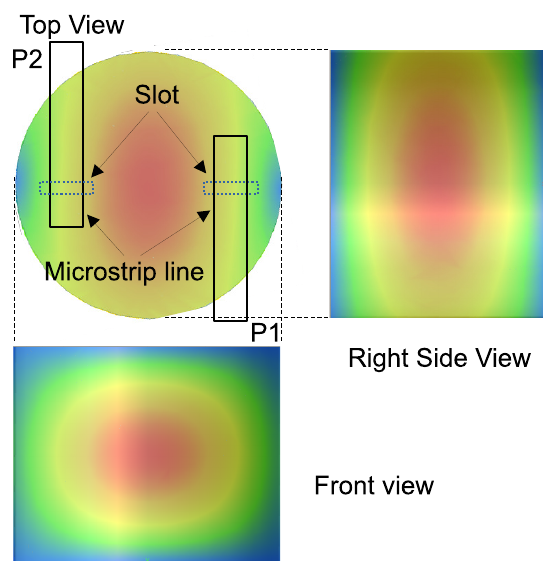
Figure 8. Electric field strength in the cavity resonator for TE111 mode.